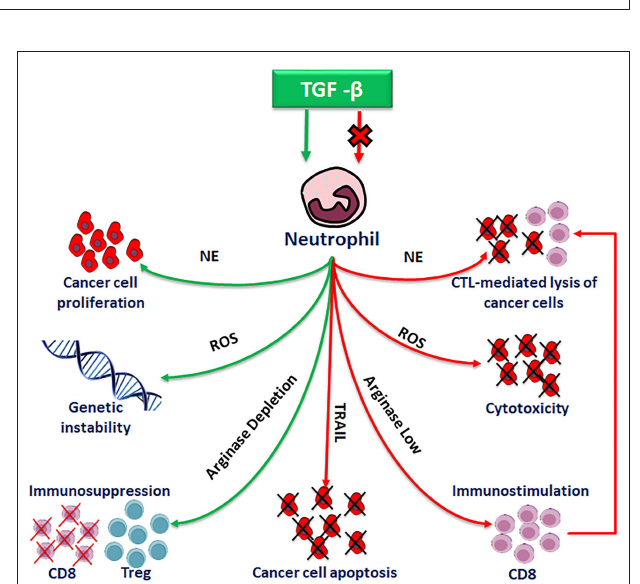
FIGURE 3 | N1 and N2 TAN polarization and their activity.